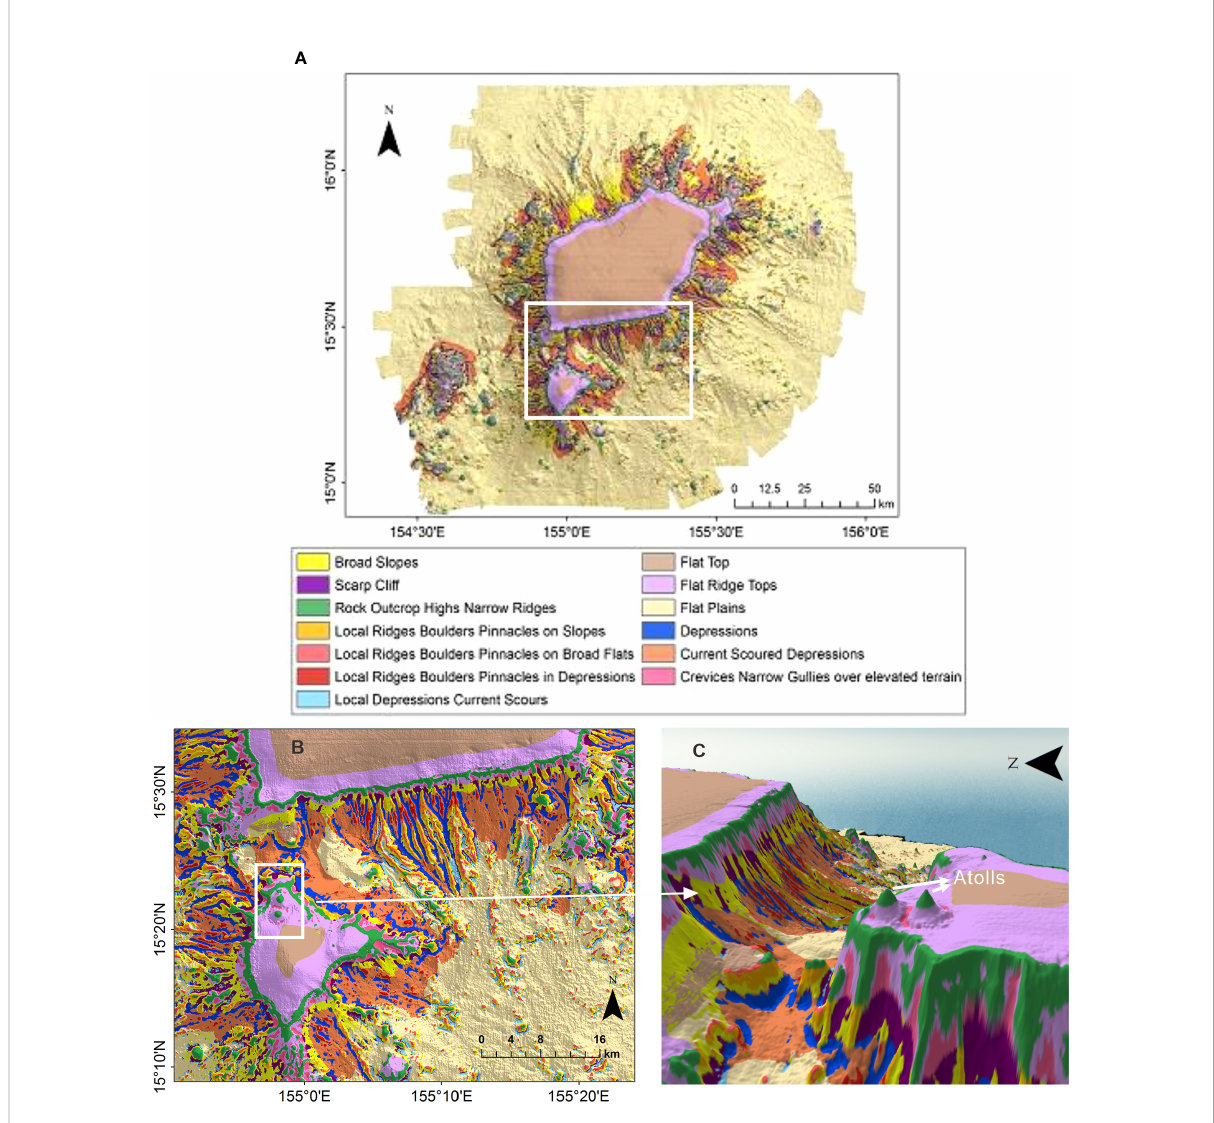
FIGURE 5 Structural zone classi fi cation maps: (A) structural zone classi fi cation and (B) structural zones of the southern part. The two peaks shown in the white box were inferred as the atolls. (C) 3D view of the